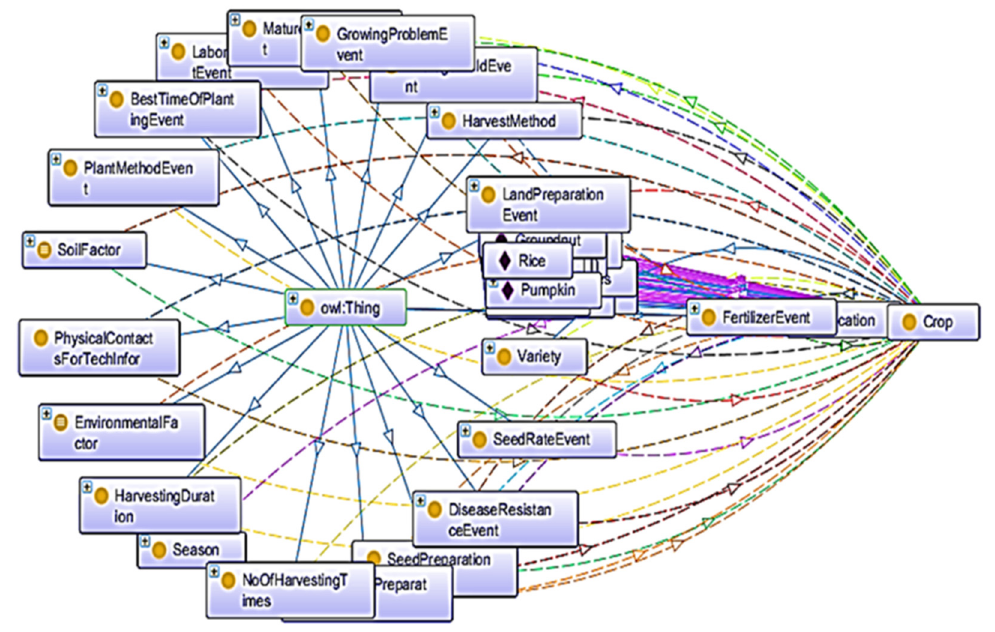
Figure 7. A general representation of an ontology in the agriculture domain.